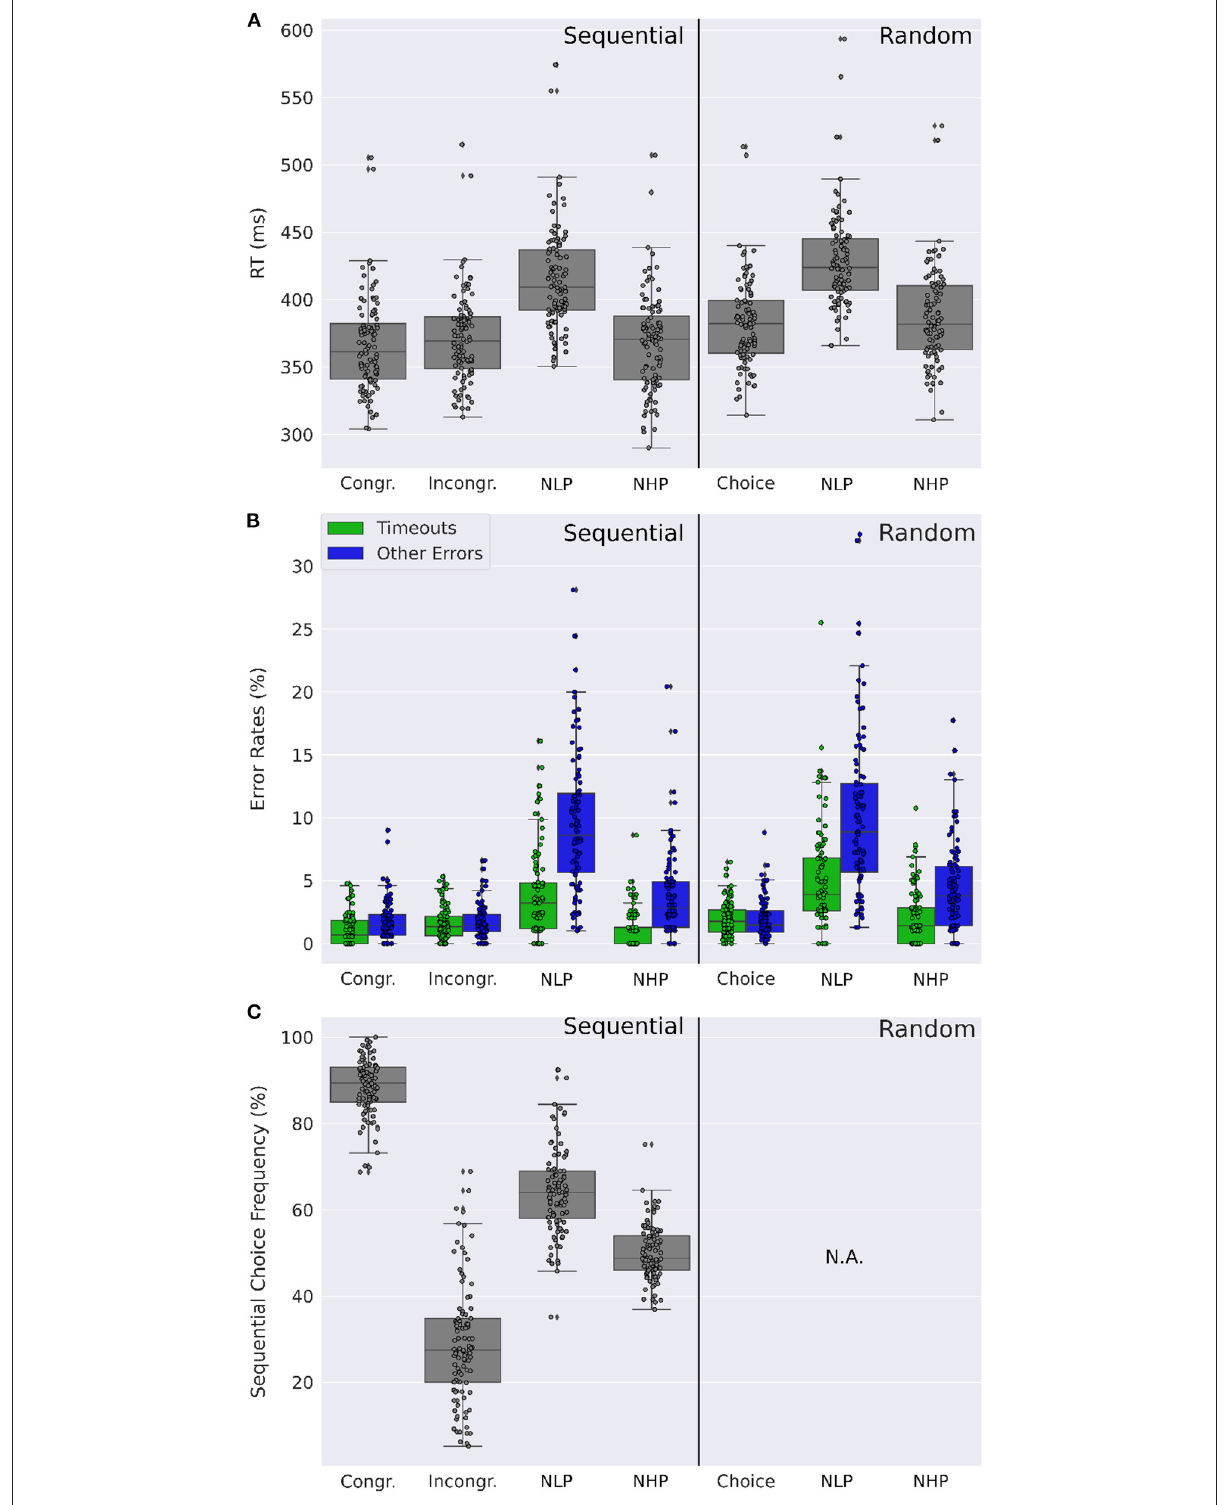
FIGURE6 Comparison of dual-target trials. (A) Distribution of participants’ mean reaction times for different types of dual-target trials: Choice trials [Congruent (Congr) and Incongruent (Incongr) in the sequential condition], neutral low reward-probability (NLP) and neutral